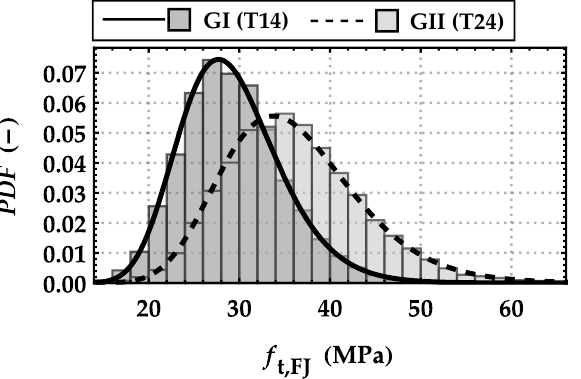
Table 10. Main statistics of the tensile strength parallel to the grain ( f t,FJ ) of 1.5 × 10 4 simulated finger joints and of the tensile strength parallel to the grain ( f t,0,b ) of 1.5 × 10 4 simulated boards featuring w b = 150 mm and l b = 2 m.